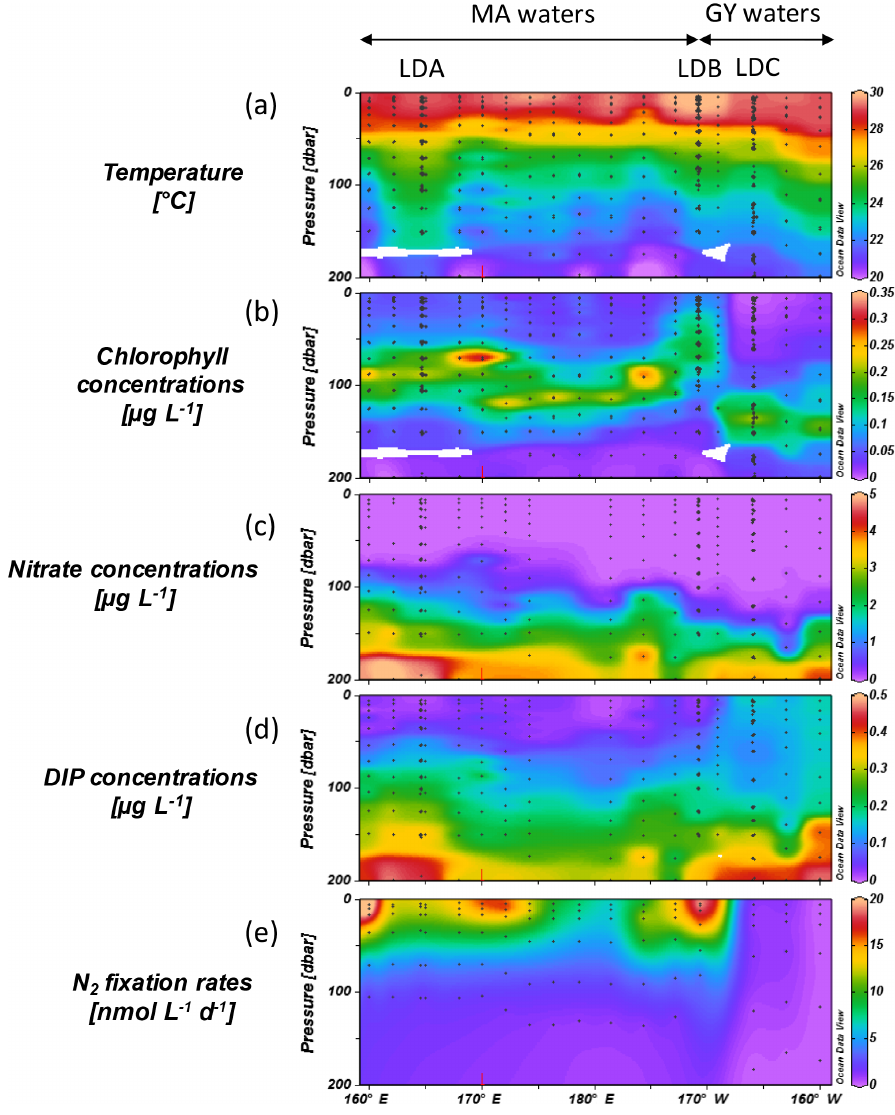
Figure 2. Horizontal and vertical distributions of (a) seawater temperature ( ◦ C), (b) chlorophyll fluorescence (µgL − 1 ), (c) NO − (d) DIP (µmolL − 1 ) and (e) N 2 fixation rates (nmolNL − 1 d − 1 ) across the OUTPACE transect. LD stations are noted and the extent of the two defined sub-regions: MA: Melanesian archipelago waters, GY: South Pacific Gyre waters. Y axis: pressure (dbar), X axis: longitude; black dots correspond to sampling depths at the various SD and LD